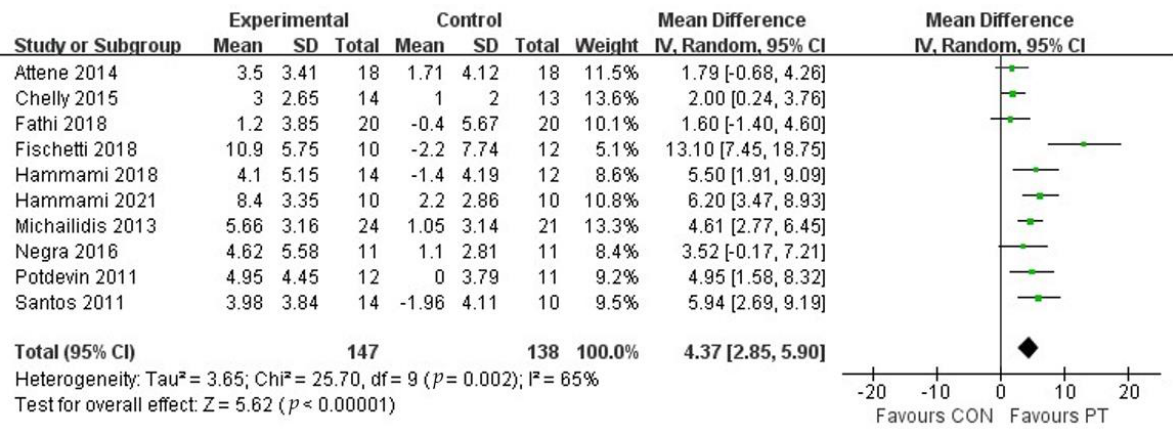
Figure 5. Forest plot of SJ of experimental and control groups.